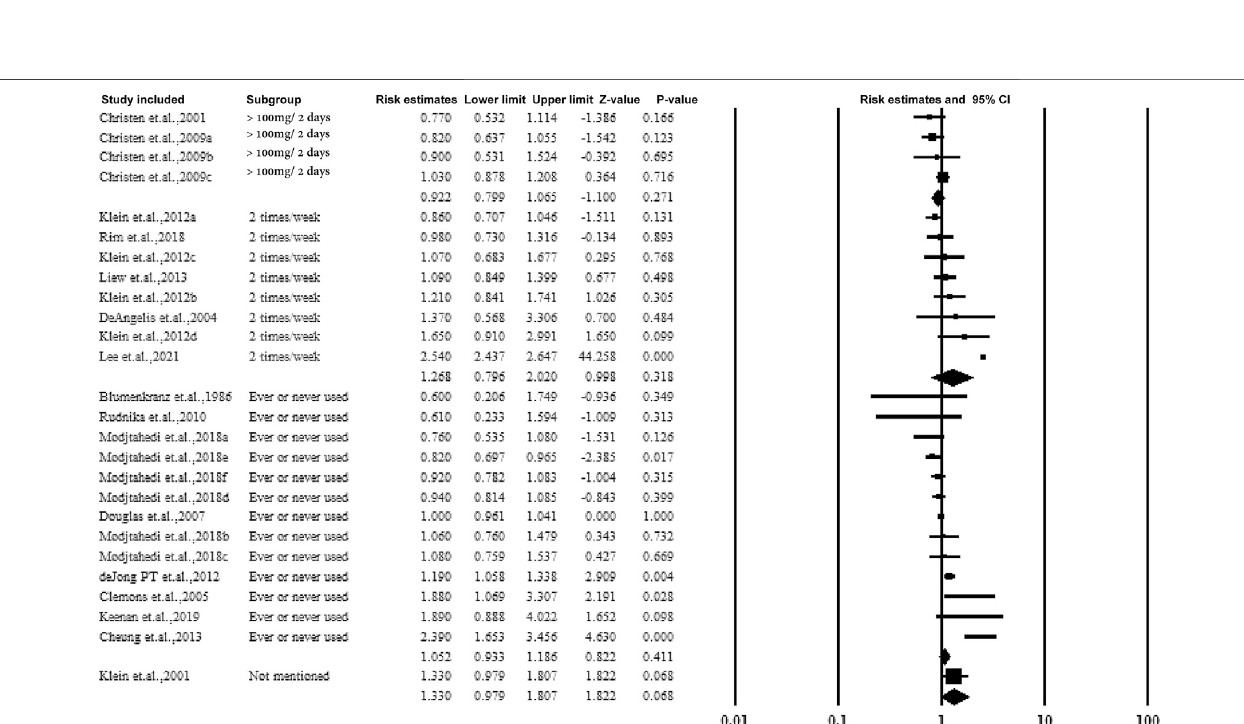
FIGURE 5 | Summarized subgroup analysis according to the dose or frequency of taking aspirin.